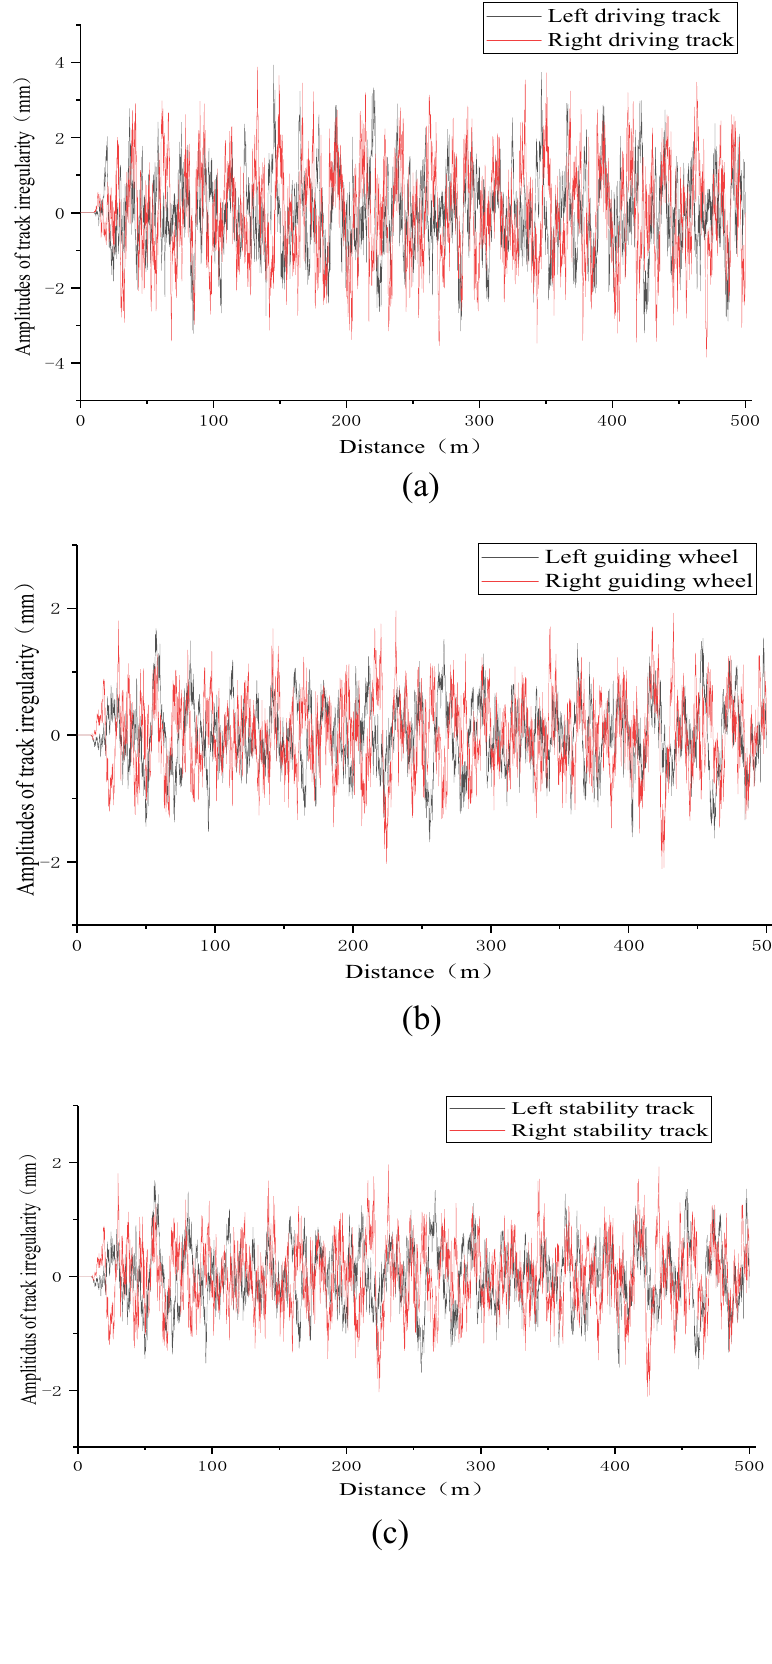
Fig. 8 Field test data of STM track irregularity. a driving wheels; b guiding wheels; c stability